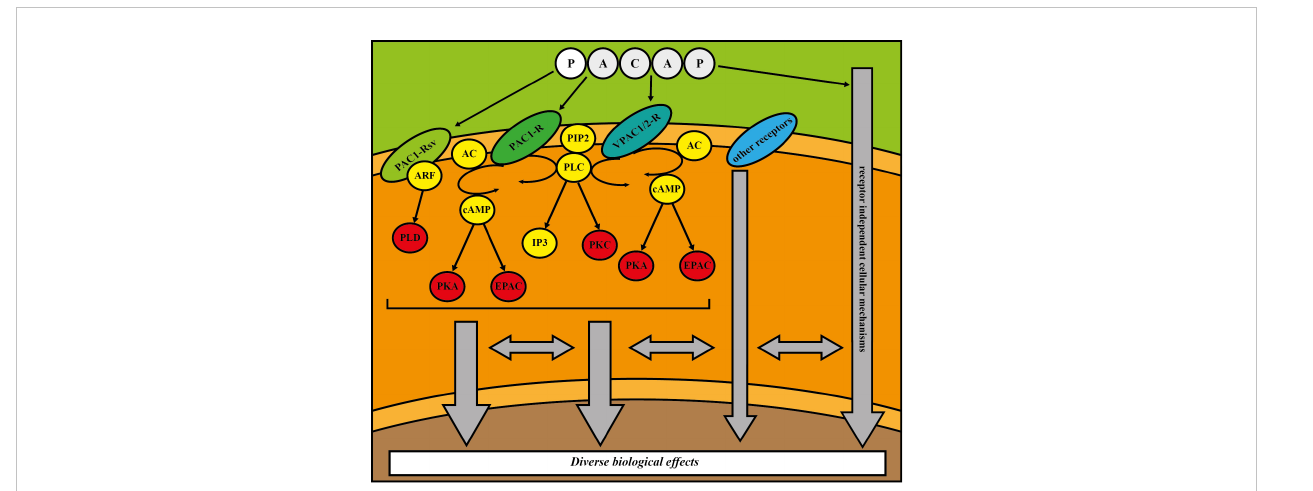
FIGURE 1 Schematic drawing of the possible signaling pathways regulated by PACAP. (AC = adenylate cyclase, ARF = adenosine diphosphate ribosylation factor, cAMP = cyclic adenosine monophosphate, EPAC = exchange proteins activated by cAMP, IP3 = 1,4,5 – inositol trisphosphate, PACAP = pituitary adenylate cyclase activating polypeptide, PAC1 – R = PACAP type I receptor, PAC1 – Rsv = PACAP type I receptor splice variants, PIP2 = phosphatidylinositol bisphosphate, PKA = protein kinase A, PKC = protein kinase C, PLC = phospholipase C, PLD = phospholipase D, VPAC1/2 – R = Pituitary adenylate cyclase – activating polypeptide type II receptor 1 or